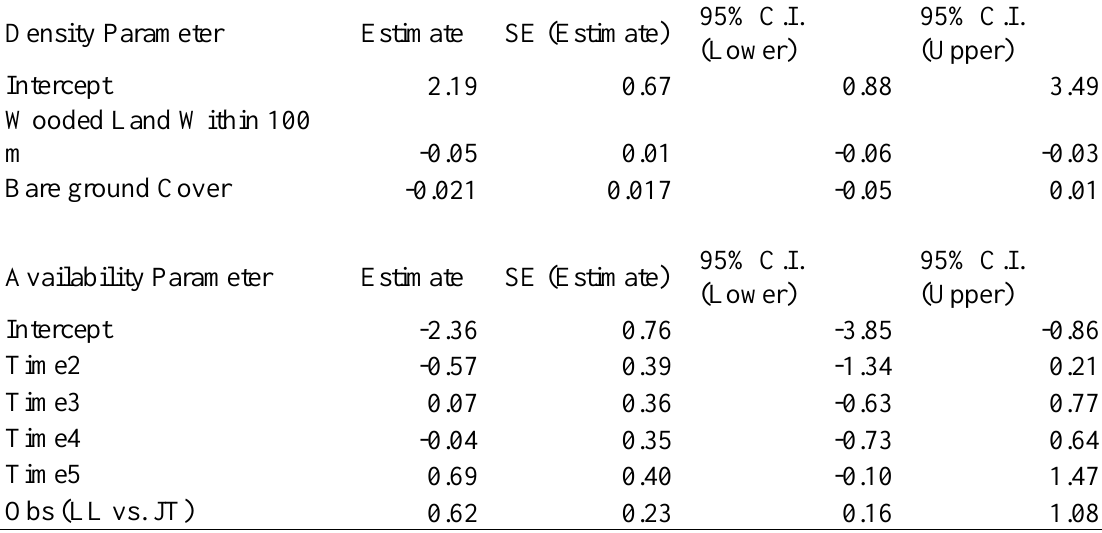
Table A2.J . Third-highest-ranking hierarchical distance-sampling model (AIC ∆ AIC =0.58, AIC weight=0.15) for Savannah Sparrows along 34 transmission line study sites in c Winnipeg, Manitoba, Canada in 2007 (n=102 surveys), assuming a uniform detection probability with increasing distance of birds from the transect line and effects of time of morning and observer experience but not Julian date on availability for